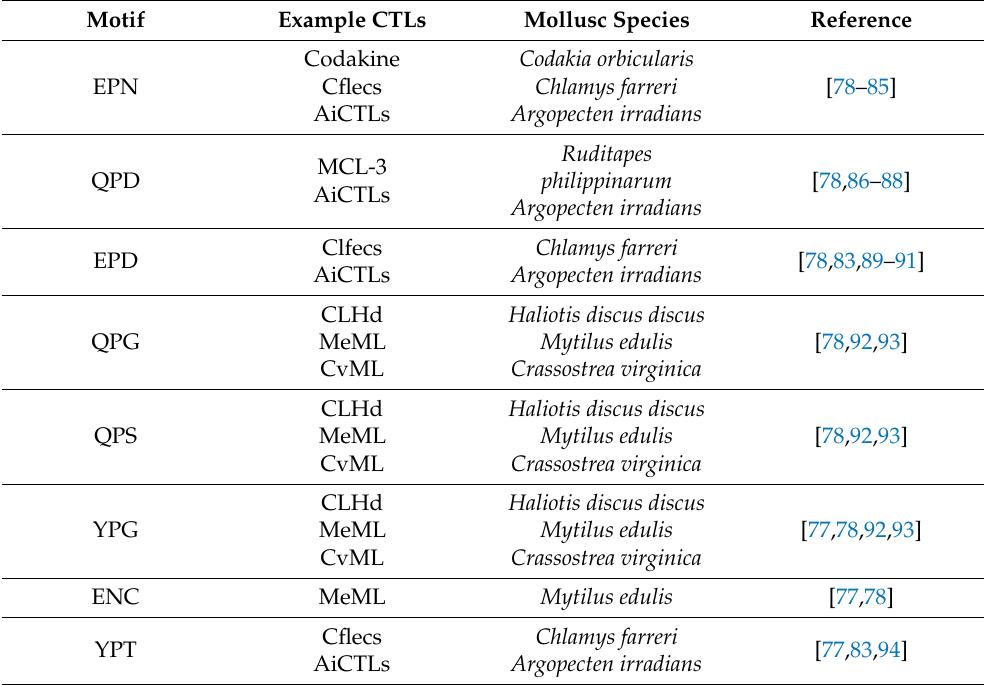
Table 2. Mollusc motifs determining the affinity of carbohydrates binding to ‘Site 2’ of CRDs. The first column indicates the seven described motifs. The second column displays CTLs that express the various motifs, and the third column lists mollusc species containing the CTLs and motifs. Table derived from